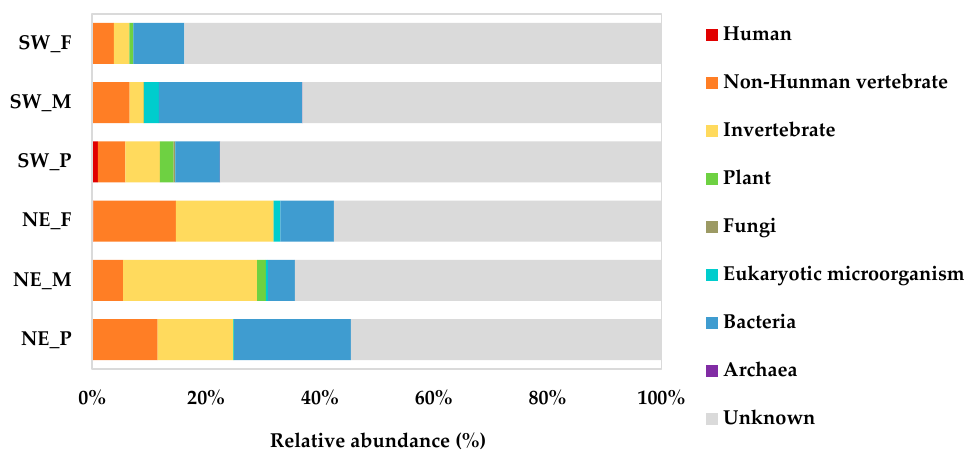
Figure 1. The distribution of viral contigs by host range in six soil viromes. According to the host range on ViralZone, viruses were classified into eight groups. In view of increased attention on the viruses which can infect humans, these viruses were independent from vertebrate viruses. Eukaryotic host: human, non-human vertebrate, invertebrate, plant, fungi, eukaryotic microorganism. Prokaryotic host: bacteria, archaea.